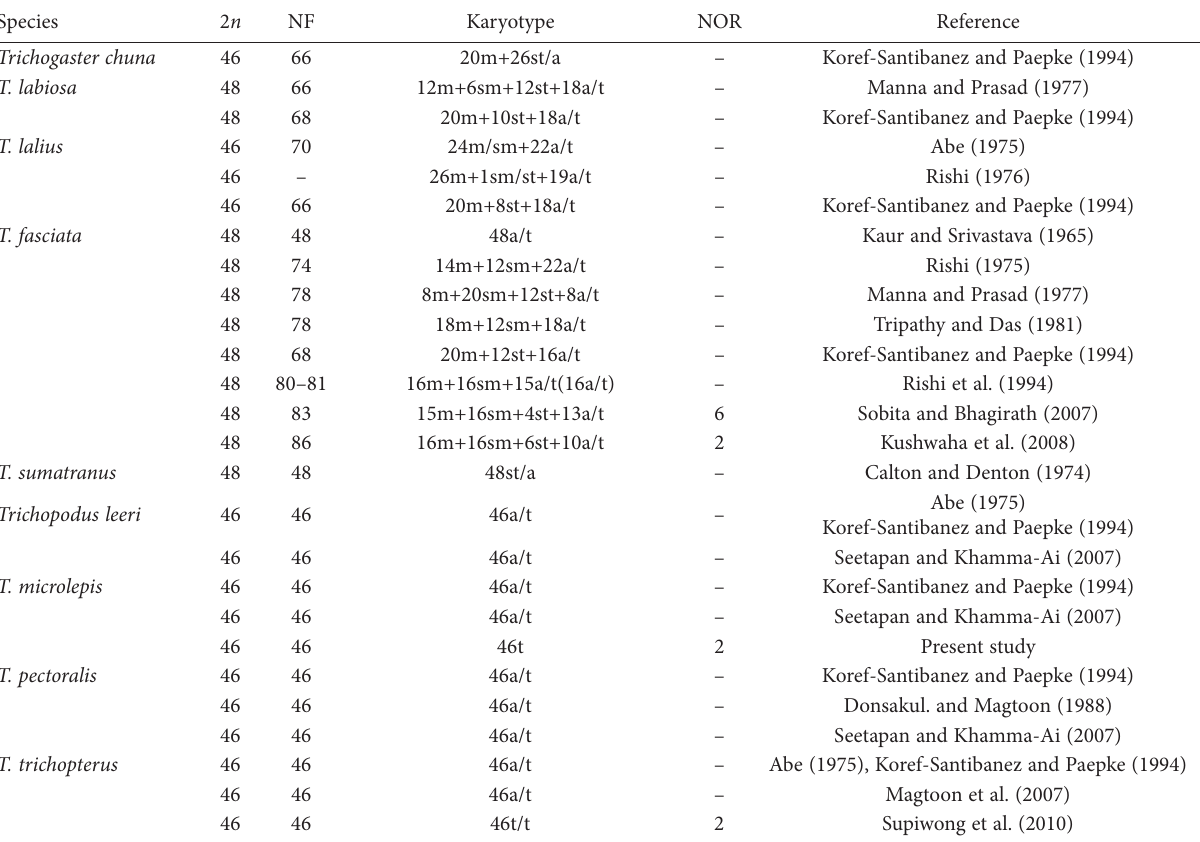
Table 1. Karyotype characteristics of some species in the subfamily Trichogastrinae. Species 2 n NF Karyotype NOR